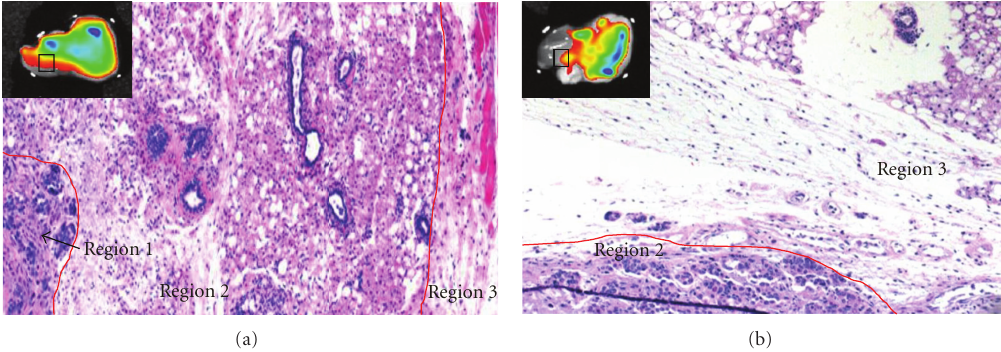
Figure 6: H&E stained sections correlated to the regions (square box) of the examined tumor. (a) Dorsal side; (b) Ventral side. Cancer cells were absent in region 2 of the dorsal side. Cancer cells were detected in region 2 of the ventral side by AQD-Tn mAb probe and confirmed by H&E stained section.